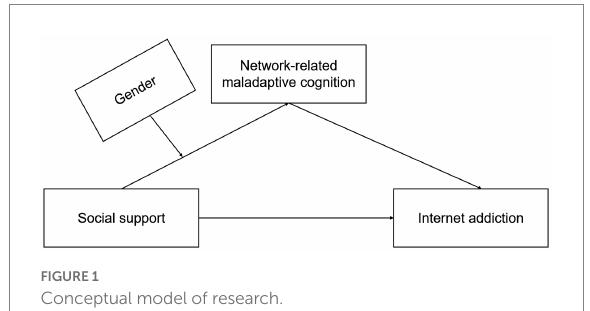
FIGURE 1 Conceptual model of